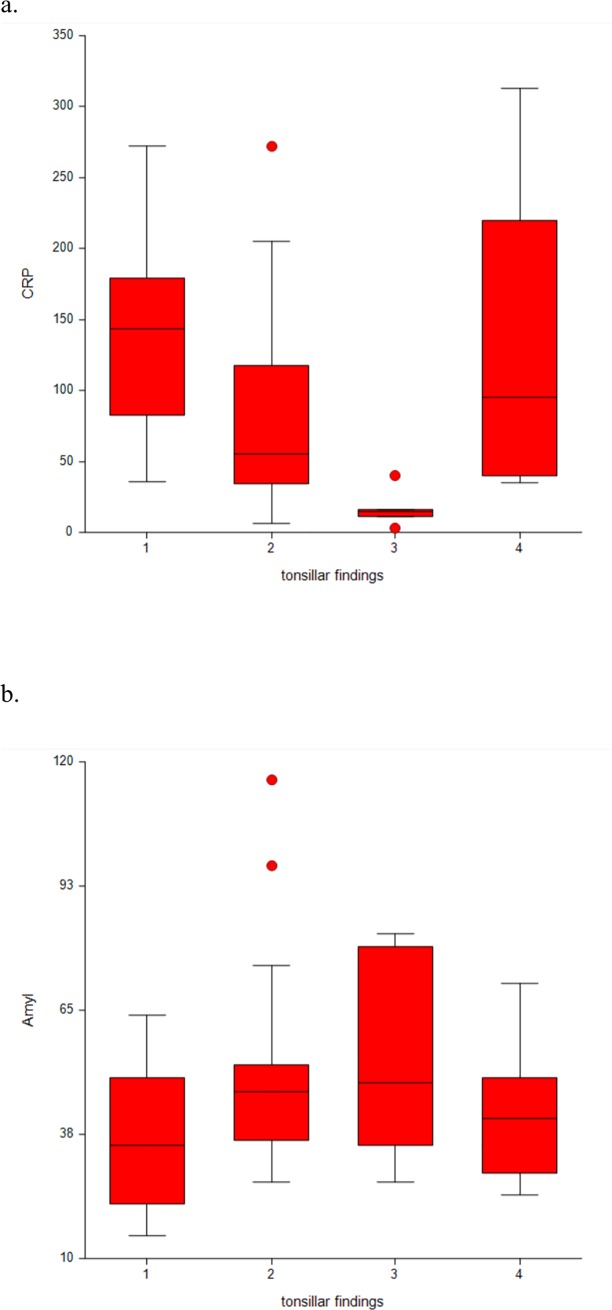
Distribution of serum proteins in PTA patients with different tonsillar findings.(A) C-reactive protein (S-CRP) and (B) amylase (S-Amyl). 1, tonsillar erythema; 2, tonsillar exudate; 3, no findings; 4, tonsillar erythema and exudate.